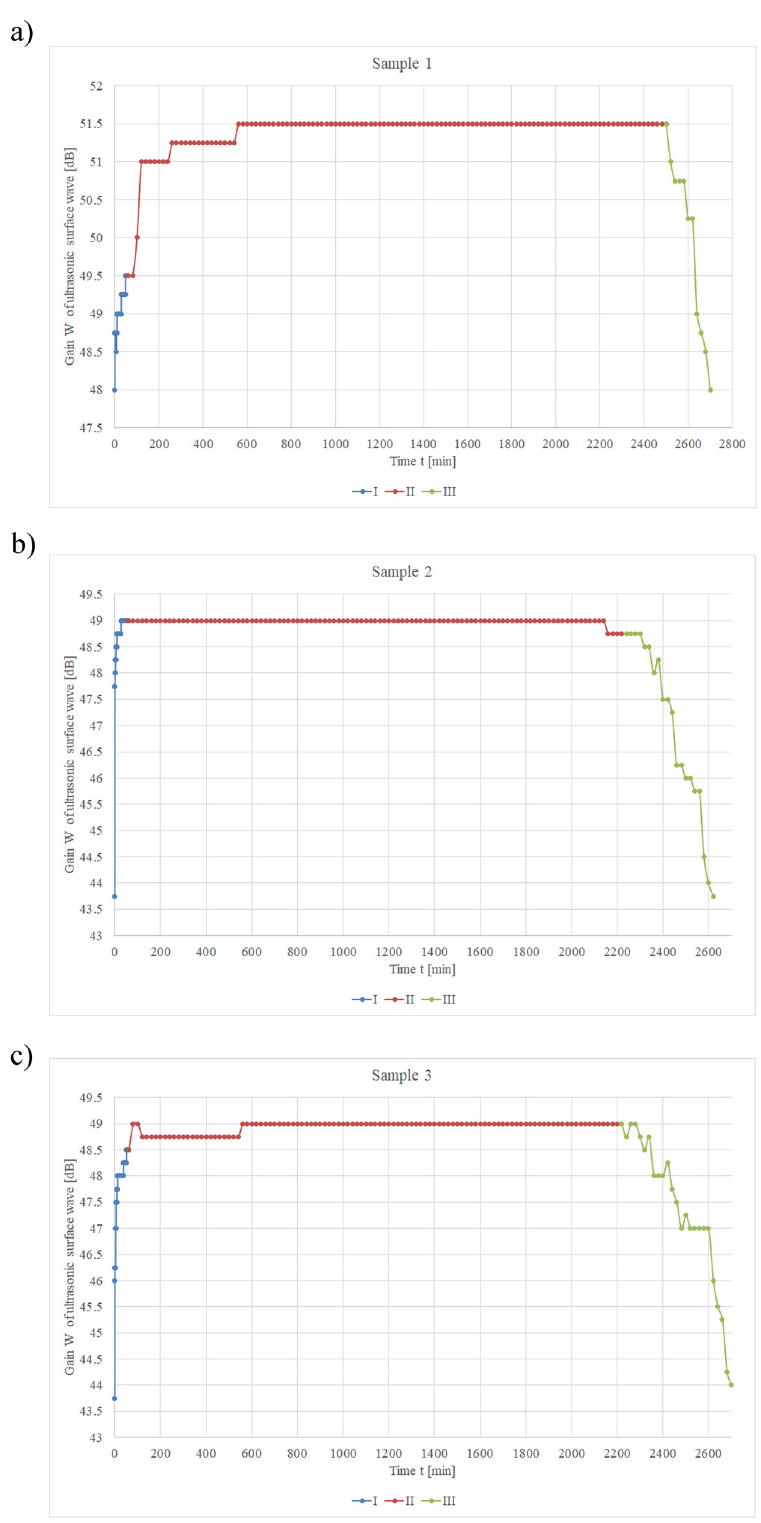
Figure 5: Ultrasonic wave gain waveform during the process of constitution and degradation of the coating – substrate interface: ( a ) sample 1, ( b ) sample 2 and ( c ) sample 3; I – constitution process, II – stable degradation and III – rapid